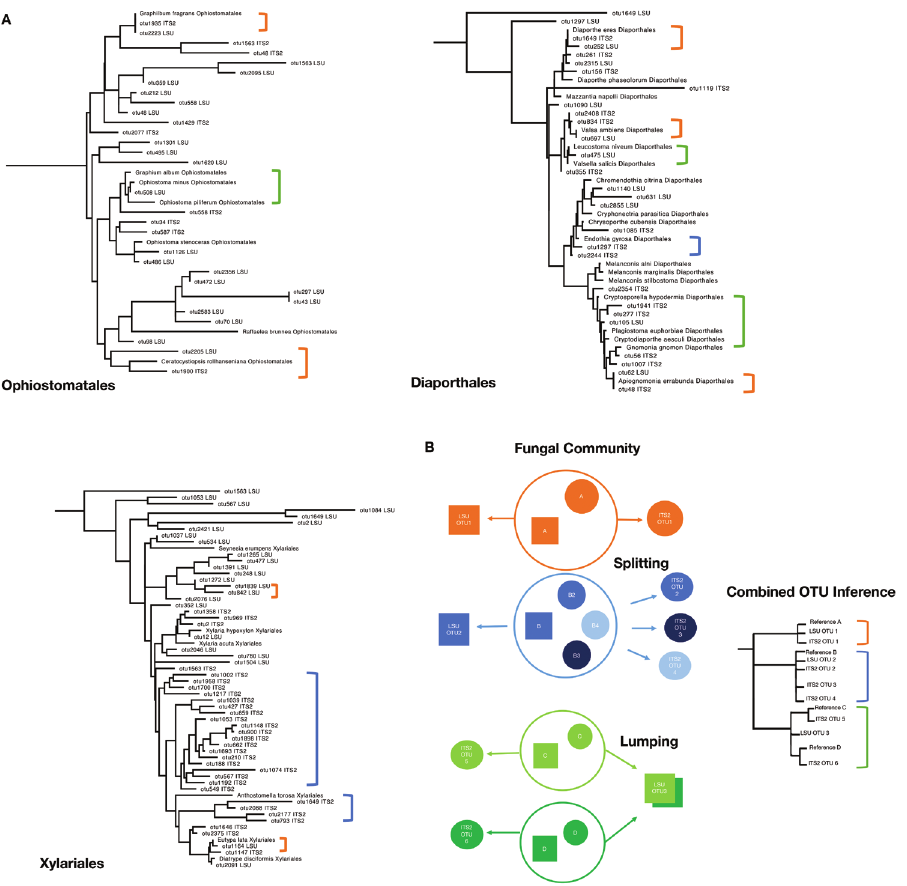
Figure 6. Order-level trees and splitting/lumping of OTUs at clustering A order-level ML trees with mixed OTU clustering thresholds (99% LSU D1-D2, 98% ITS2). Full tree in supplementary materials. Leotia lubrica was used as the outgroup (not pictured). Brackets indicate reference taxa linked to an ITS2 and/or LSU OTU, with colours indicating potential splitting/lumping (blue, splitting; green, lumping; orange, 1:1) B diagram illustrating the effects of splitting and lumping of an OTU in the fungal commu- nity on the tree inference. Four hypothetical species (A to D) in a community are treated under uniform clustering thresholds for ITS2 and LSU. This may result in deviation from the 1:1 ratio of OTUs expected if each species in the community is represented equally by both markers (species A). Threshold values may be too high, resulting in splitting of species into multiples OTUs, which is likely to affect the more variable ITS2 region (species B) or may be too low, resulting in lumping of multiple species into a single OTU, likely to affect the conservative LSU region (species C and